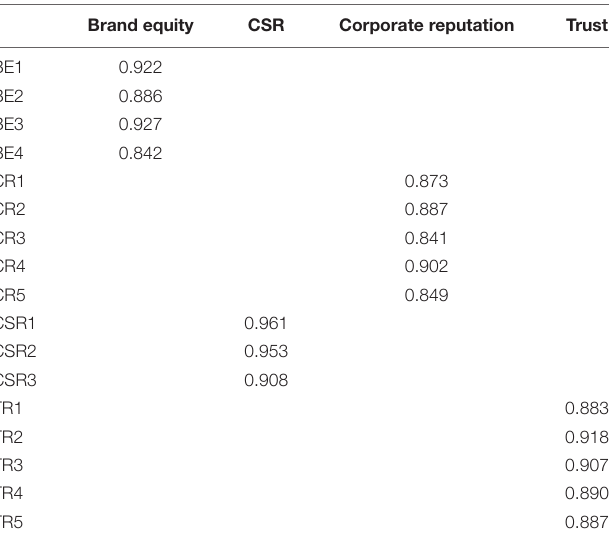
TABLE 2 | Factor loading.